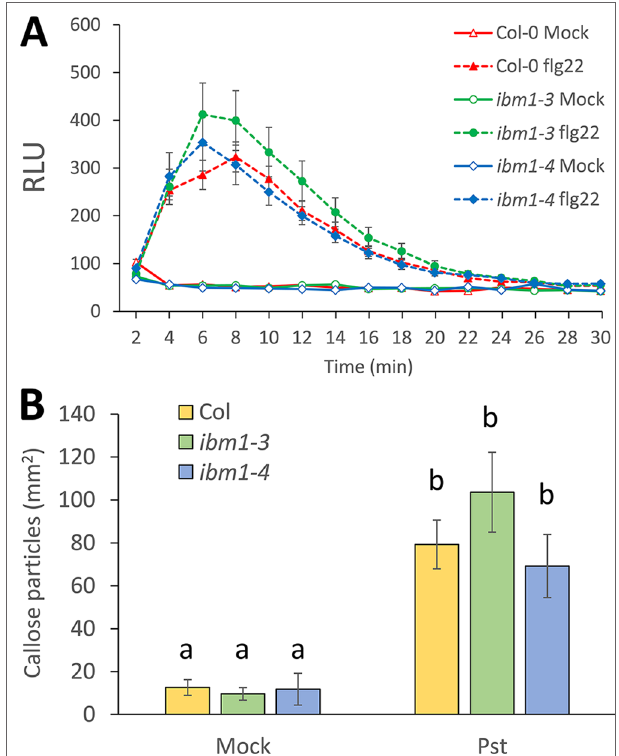
FIGURE 5 | The role of IBM1 in apoplastic PTI. (a) Reactive oxygen species production. Leaf disks from 5-week-old plants were treated with 100 nM flg22 or water (mock). Relative light units (RLUs) were evaluated at the indicated time points. Values represent average ± SEM from three independent experiments, each consisting of six leaf disks (N = 18). No significant differences to the Col-0 wild type (WT) were observed when analyzed with a paired two-tailed Student’s t -test (p < 0.05). (B) Callose deposition. Fourteen-day-old seedlings were floated in liquid 1/2 Murashige and Skoog for one night before treatment with 10 6 cfu/ml Pst DC3000 for 6 h. Equivalent volumes of 10 mM MgSO 4 were used for mock controls. Values represent average ± SEM from three independent experiments, each consisting of at least three seedlings (N = 9). No significant differences to respective Col-0 WT were observed when analyzed with a one-way ANOVA with post hoc Tukey honestly significant difference (p <